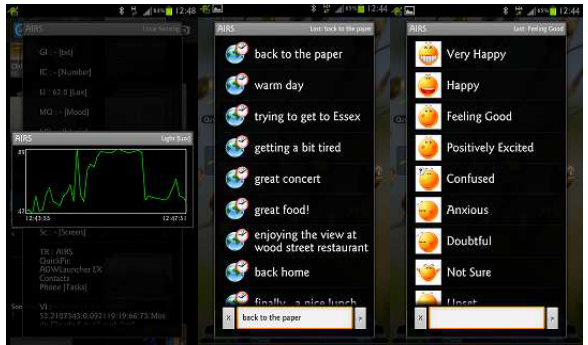
Figure 3 . AIRS Screenshots: (a) visualization;